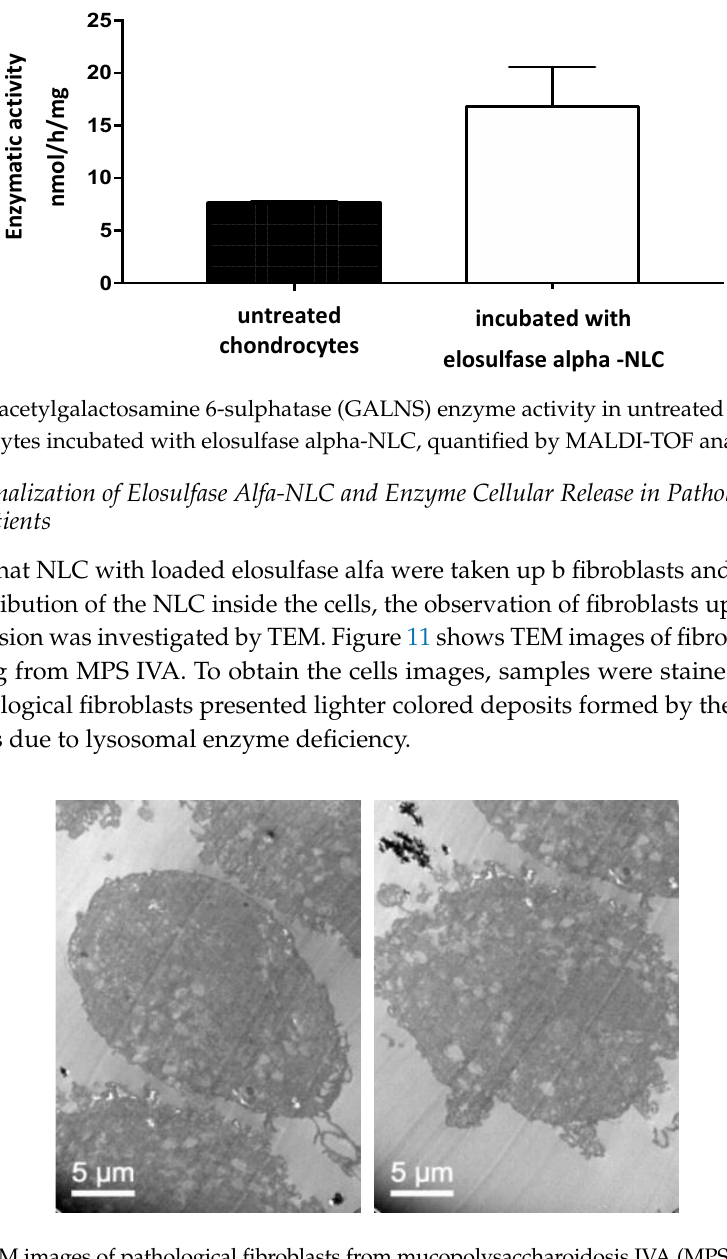
chondrocytes; Line 4—chondrocytes with elosulfase alfa-NLC.